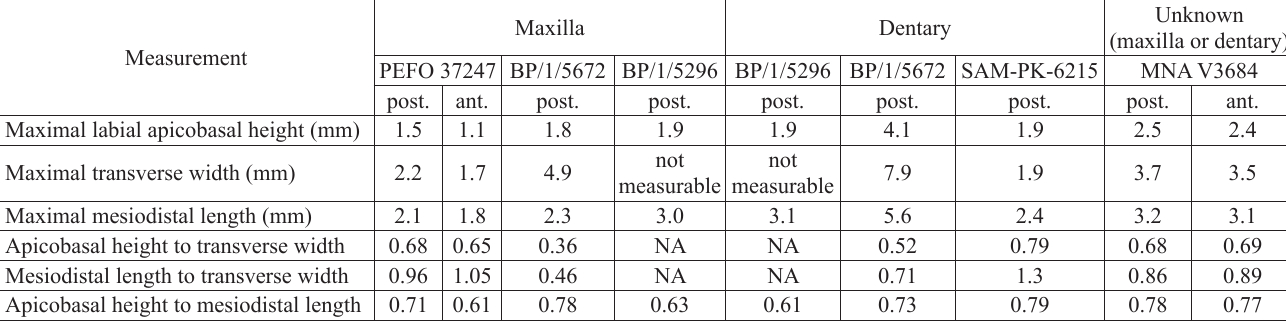
Table 1. Comparisons of tooth measurements and quotients from Palacrodon specimens. Abbreviations: ant., anterior teeth; post., posterior teeth; NA, not